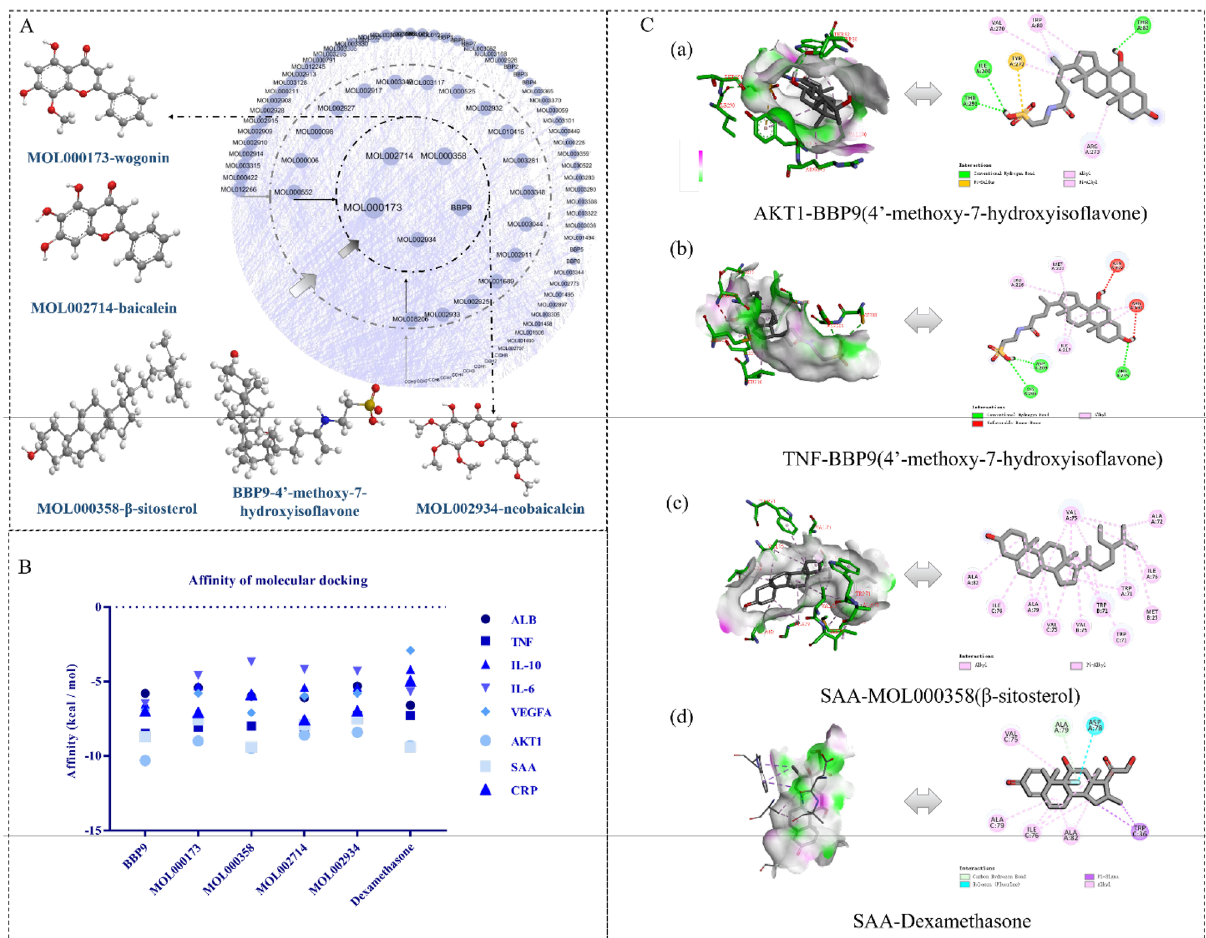
Figure 5. ( A ) The core components, 4’-methoxy-7-hydroxyisoflavone, baicalein, β-sitosterol, wogonin and neobaicalein, were selected from the TRQ-component-target-AECOPD network. ( B ). The affinity results of molecular docking. ( C ). 3D interaction diagrams of key targets and their corresponding best-matched components. ( a ) 3D interaction diagram of 4’-methoxy-7-hydroxyisoflavone in the active sites of AKT1; ( b ) 3D interaction diagram of 4’-methoxy-7-hydroxyisoflavone in the active sites of TNF-α; ( c ) 3D interaction diagram of β-sitosterol in the active sites of SAA; ( d ) 3D interaction diagram of Dexamethasone in the active sites of